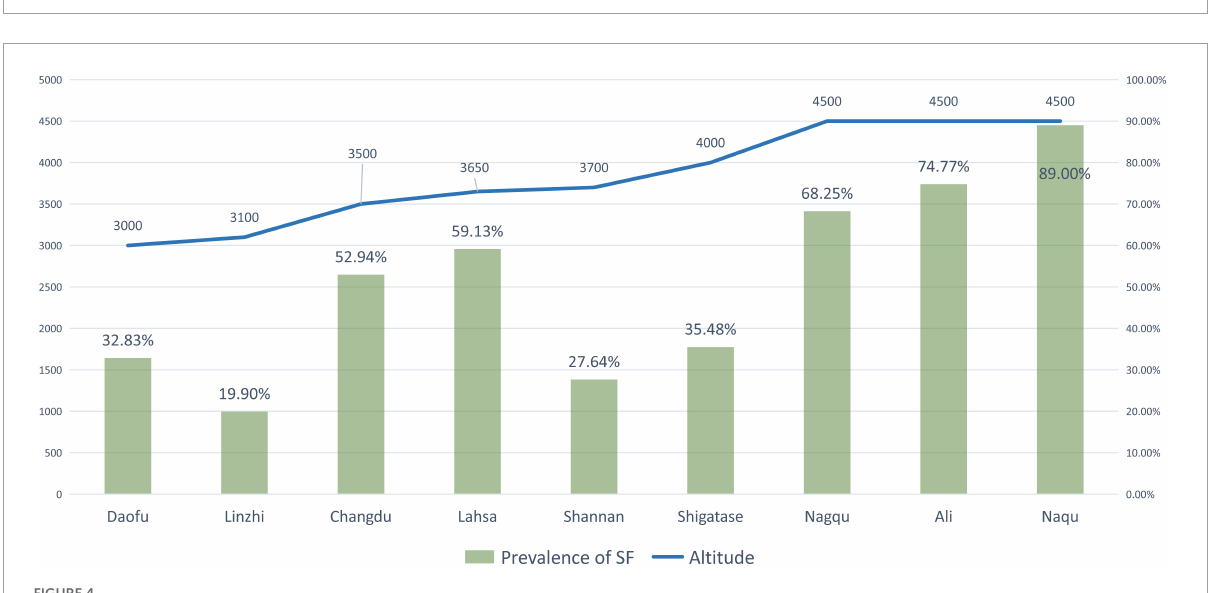
FIGURE4 The prevalence of skeletal fluorosis (SF) and the altitude of surveyed areas (The line graph shows the altitude of the research site, and the bar graph shows the reported prevalence of SF at the research